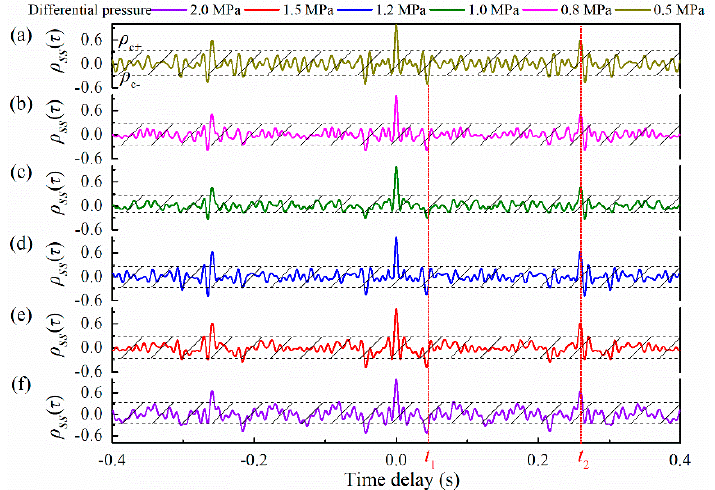
Figure 14. Autocorrelation coefficients of leak acoustic signals generated under differential pressures of ( a ) 0.5 MPa, ( b ) 0.8 MPa, ( c ) 1.0 MPa, ( d ) 1.2 MPa, ( e ) 1.5 MPa, and ( f ) 2.0 MPa.